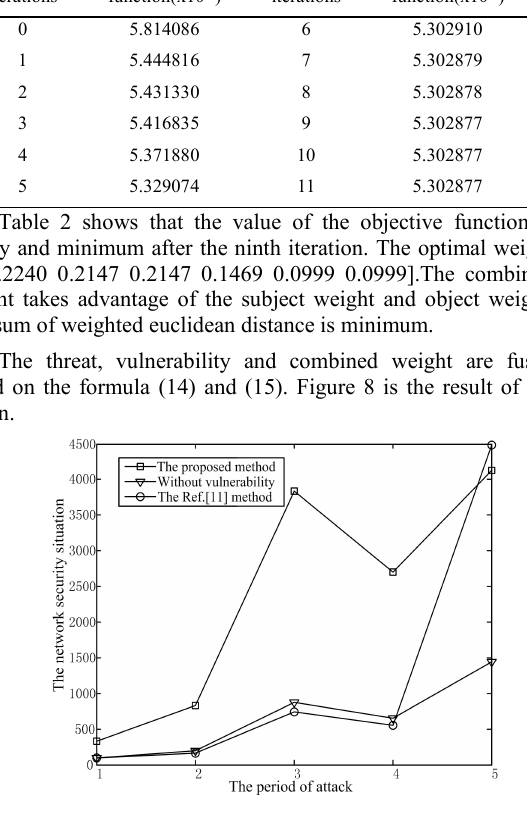
Figure 8: Comparison of the network security